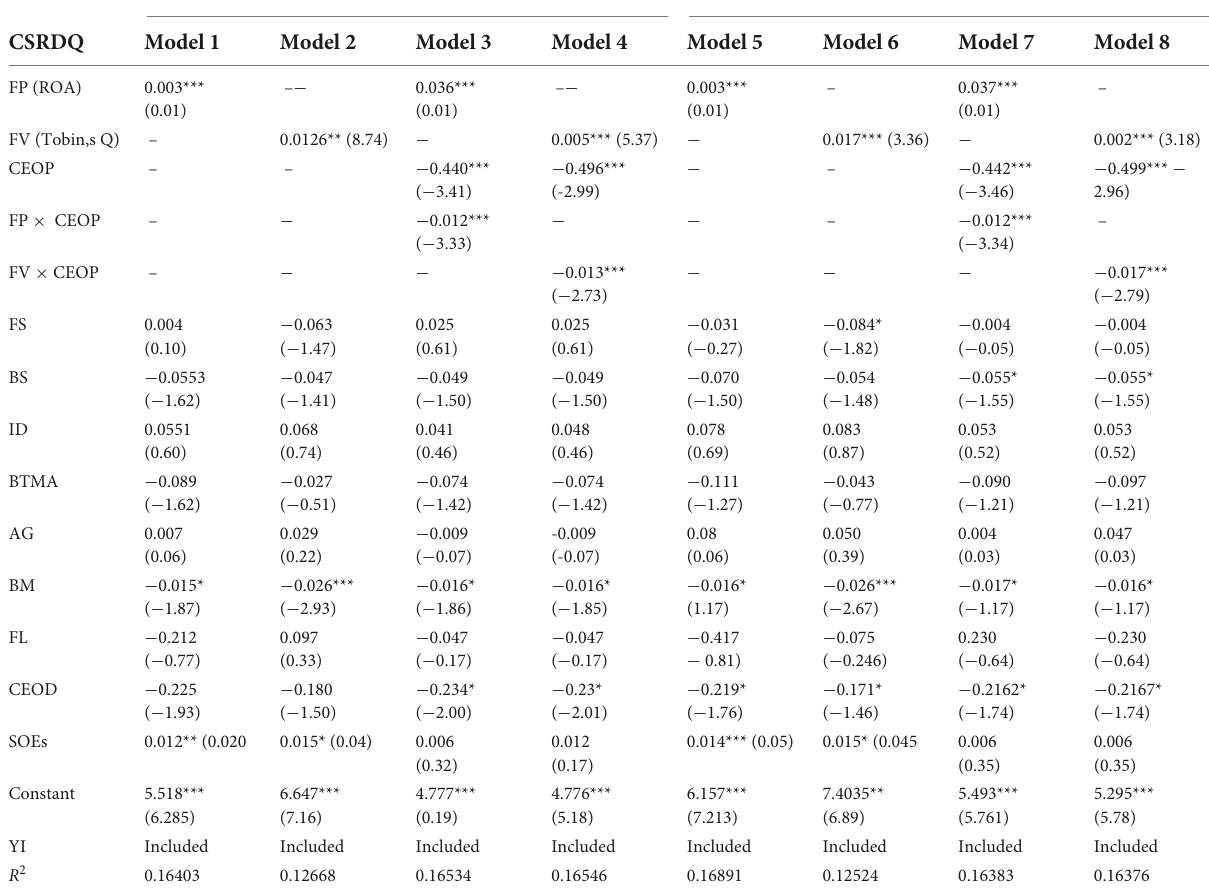
TABLE 6 Regression results with one year lagged OLS and two-stage least square (2SLS).